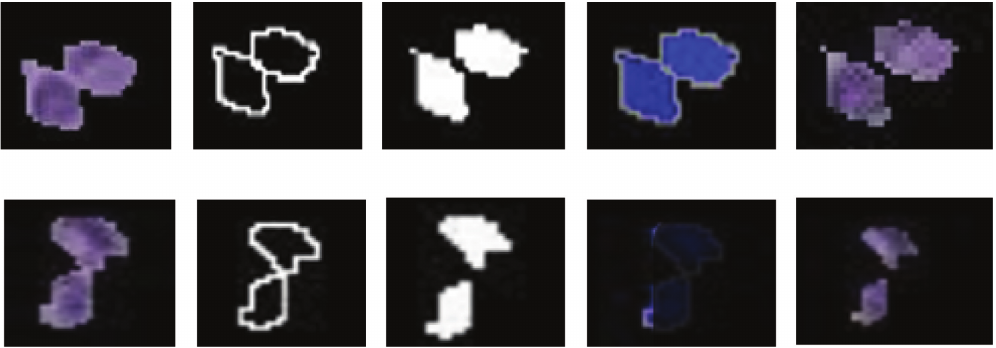
Figure 6: Sample image of the